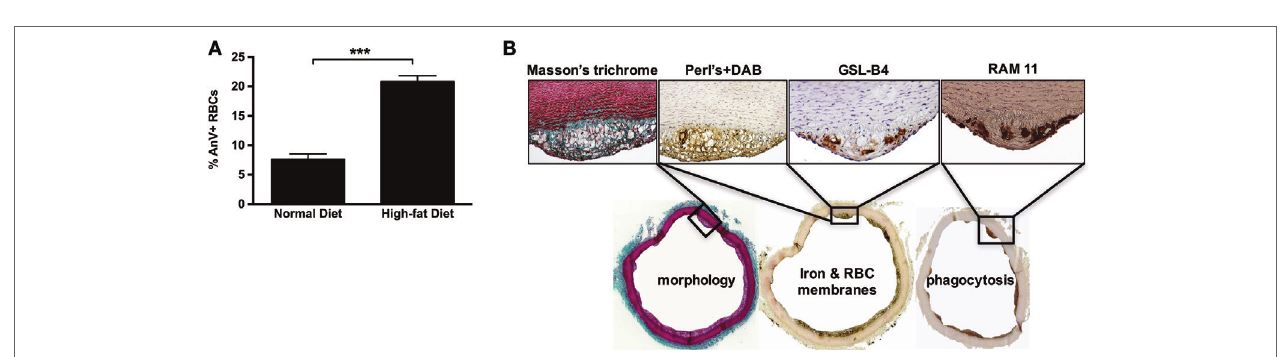
FigUre 8 | High-cholesterol diet induces red blood cell accumulation in rabbit foam cells. (a) After consuming a hypercholesterolemic diet for 3 months, rabbits showed significantly increased percentages of circulating Annexin V + RBCs (*** p < 0.001; Mann–Whitney’s test). (B) The consumption of a hypercholesterolemic diet was associated with the development of focal subendothelial lesions characterized by the predominance of foam cells, as shown by Masson’s trichrome staining. These foam cells were redox-active iron-positive based on Perls + DiAminoBenzidin (DAB) staining (Perls alone and DAB alone were strictly negative, not shown). They were also recognized by a rabbit RBC membrane marker (GSL-B4 lectin) and were found to express a phagocyte marker